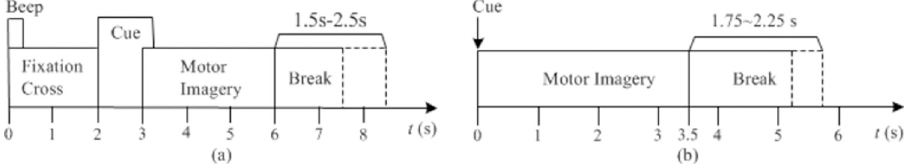
Fig 2. The timing scheme of a single trial in (a) the EEG dataset 1 and (b) the EEG dataset